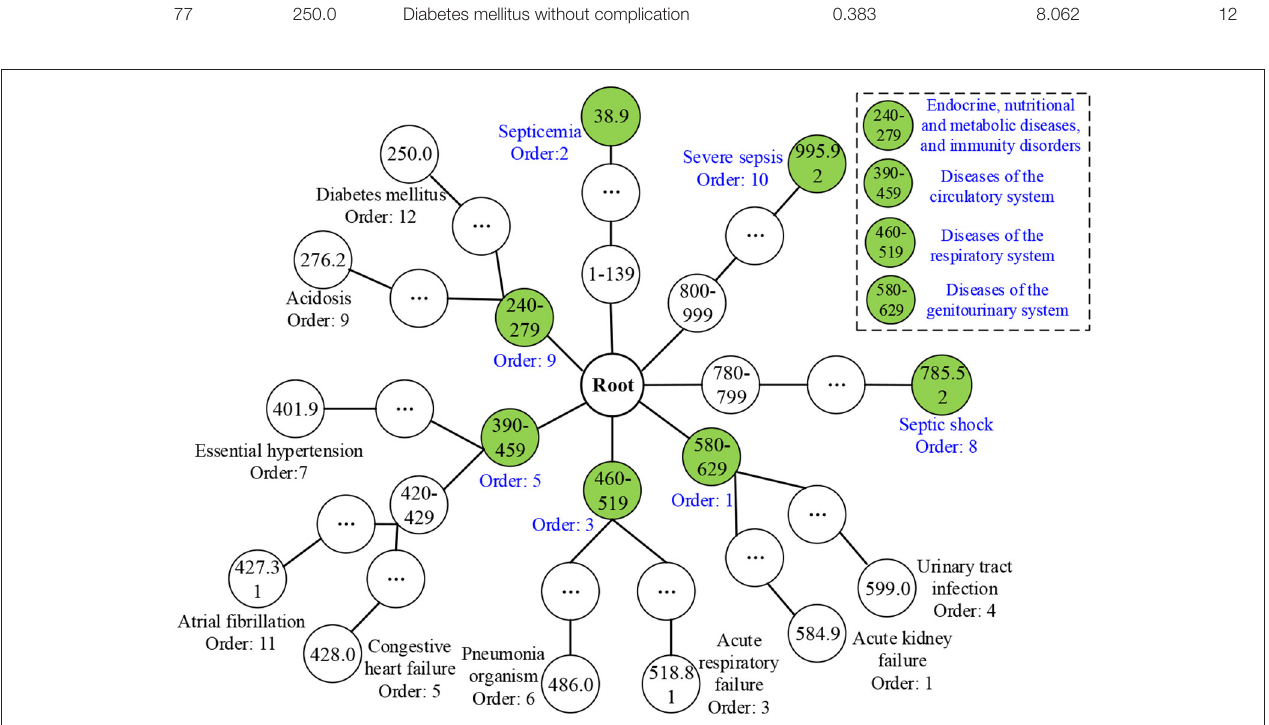
FIGURE 10 | LCoP 2 identified using the visualization of TDCoP 3 in the ontology